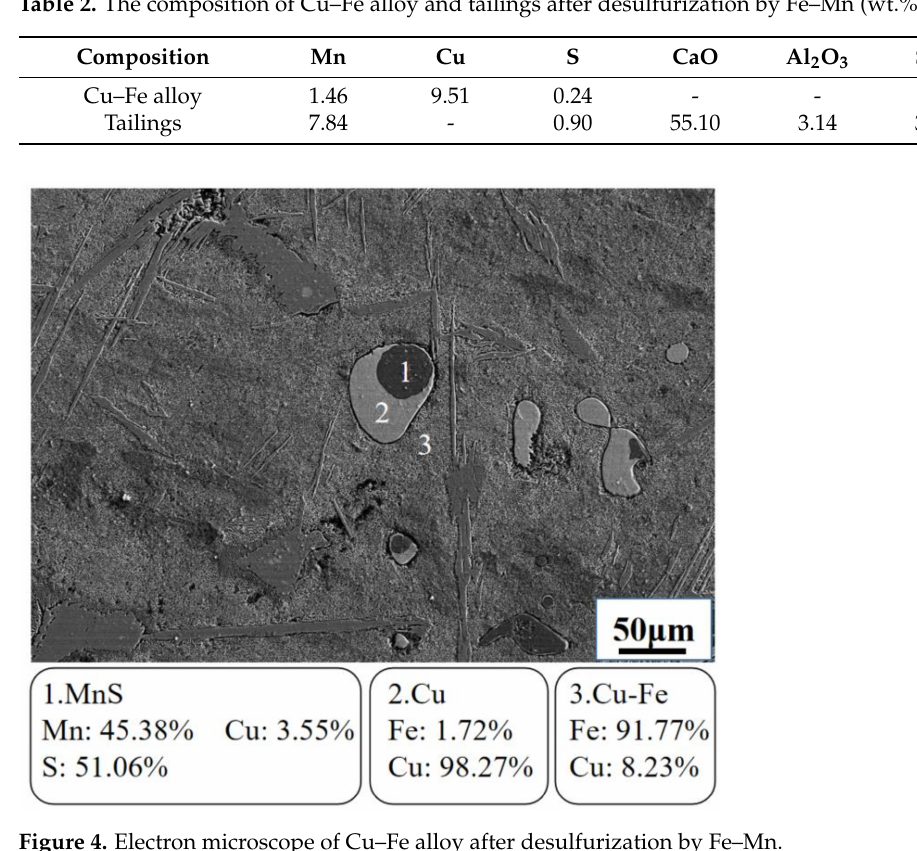
Figure 4. Electron microscope of Cu–Fe alloy after desulfurization by